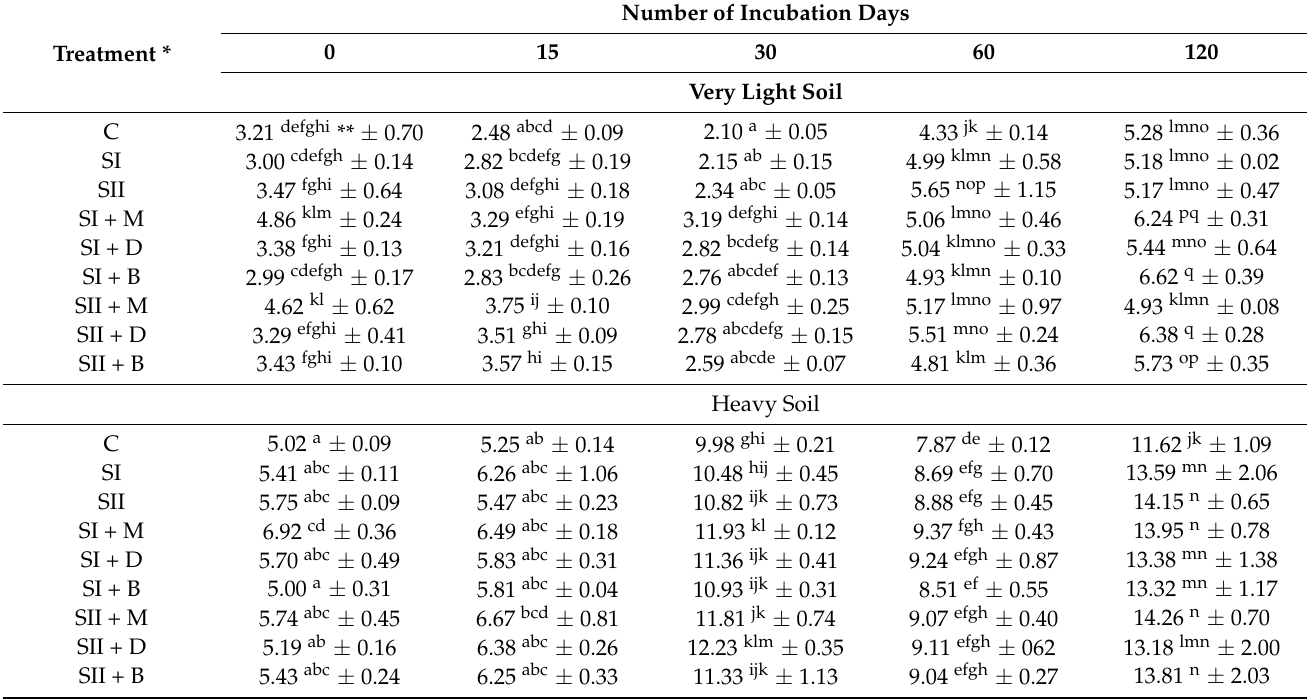
Table 5. Manganese content in very light and heavy soils throughout the incubation experiment (mg Mn kg − 1 d.m. ±